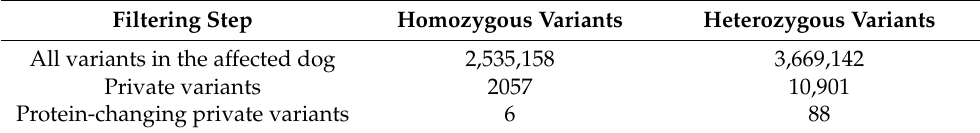
Table 1. Results of variant filtering in the affected dog against 565 control genomes.